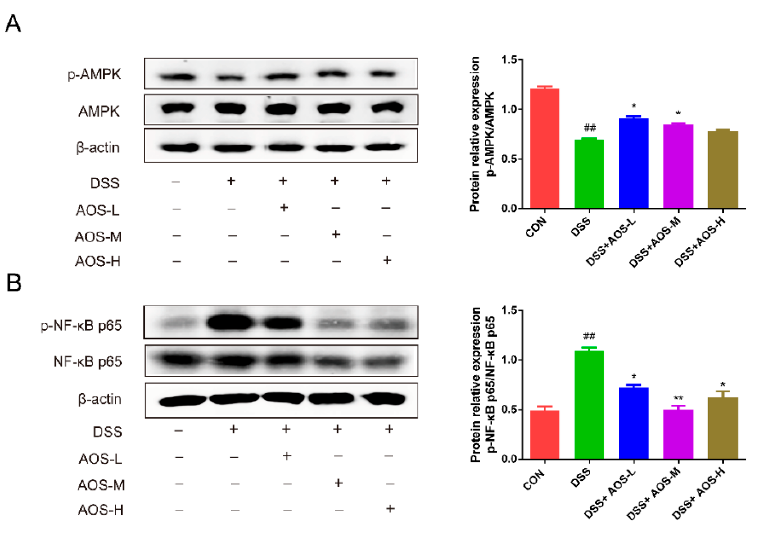
Figure 5. Effects of AOS on DSS-induced inflammation in colonic tissues. ( A ) Western blotting analysis of AMPK and p-AMPK levels in colonic tissues, with p-AMPK/AMPK being analyzed with ImageJ software. ( B ) Western blotting analysis of NF- κ B p65 and p-NF- κ B p65 levels in colonic tissues, with p-p65/p65 being analyzed with ImageJ software. ## p < 0.01 vs. Control group; * p < 0.05, ** p < 0.05 vs. LPS group; n =